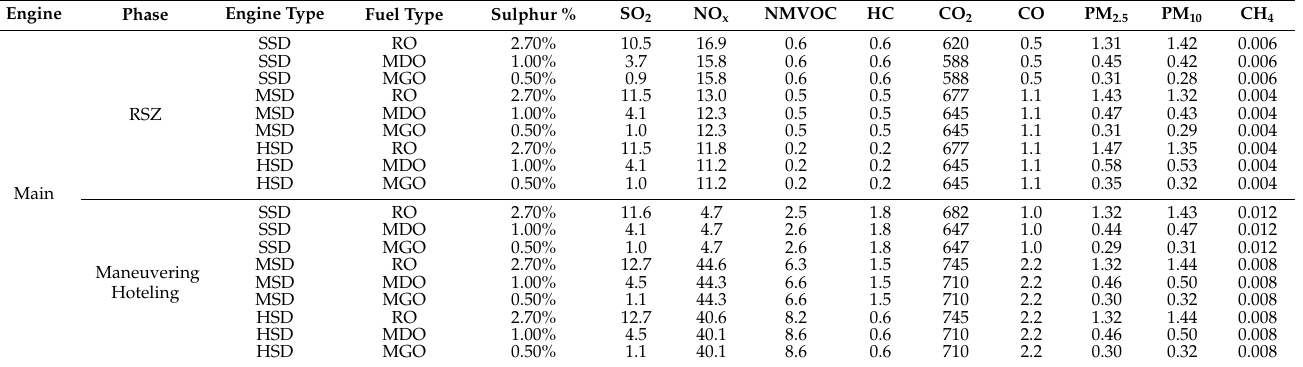
Table A3. Emission factors (g/kWh) for different engine